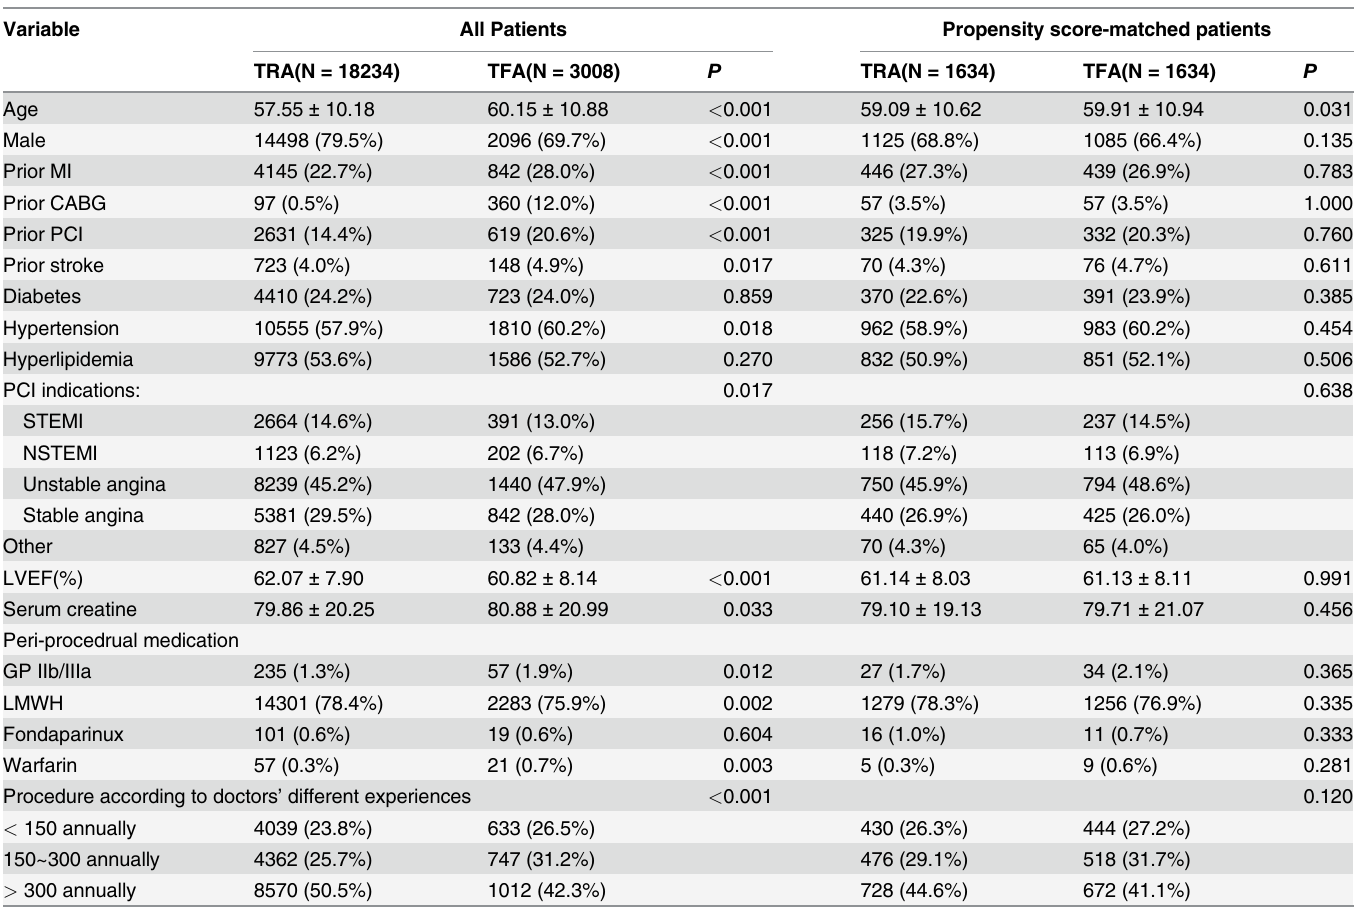
Table 1. Baseline